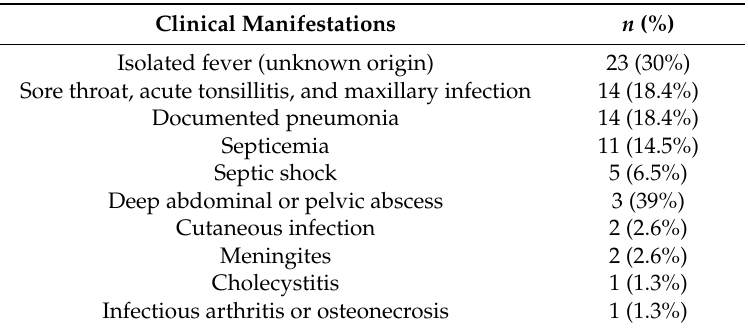
Table 3. Clinical manifestations upon hospitalization for the 76 patients.